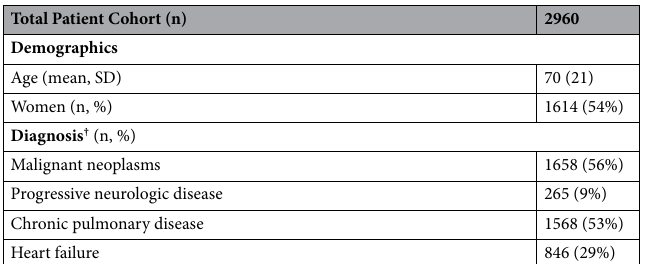
Table 1. Characteristics of patients identified from administrative claims. † Patients may be counted in more than one diagnosis group; thus percentages do not sum to 100. International Classification of Diseases, 10th Revision codes used are provided in the Supplemental Table.